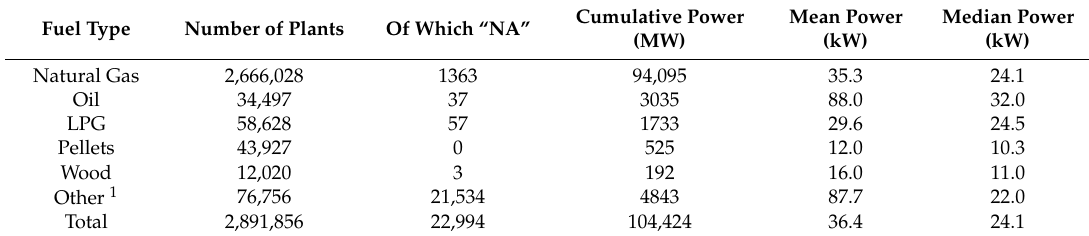
Table 1. Features of the heating systems by fuel